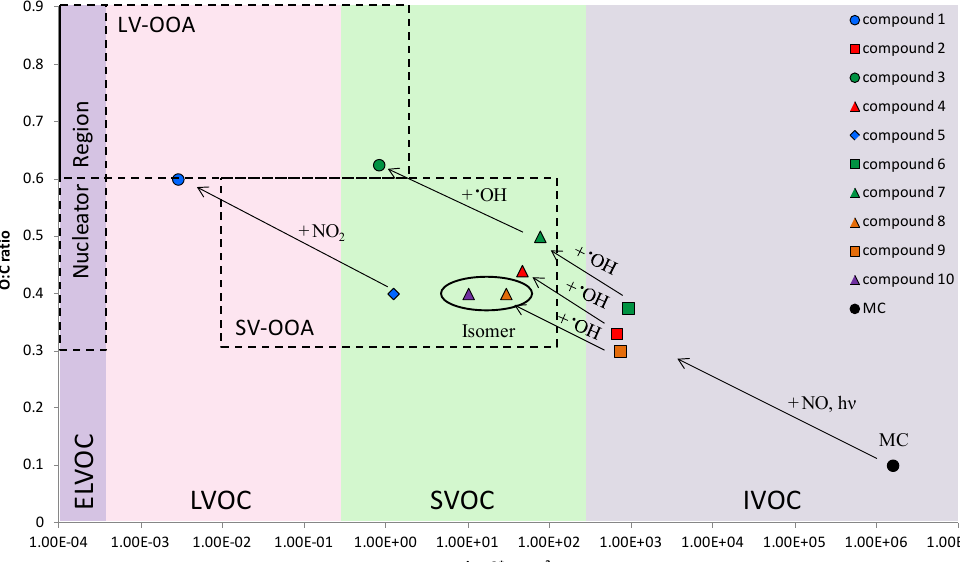
Figure 5. Oxygen to carbon ratio (O:C) and saturation concentration log C ∗ (Donahue et al., 2006b) space to show the movement of the identified SOA compounds to lower volatilities upon oxidation in MC high . Related generations of compounds are shown in the same colour. The change of shape but use of the same colour indicates a change in the SOA compound structure through the reaction with · OH radicals or NO 2 . See legend for SOA compound identification and refer to Table 2. O:C vs. log C ∗ space with associated volatilities have been redrawn from Donahue et al. (2013) and Jimenez et al.